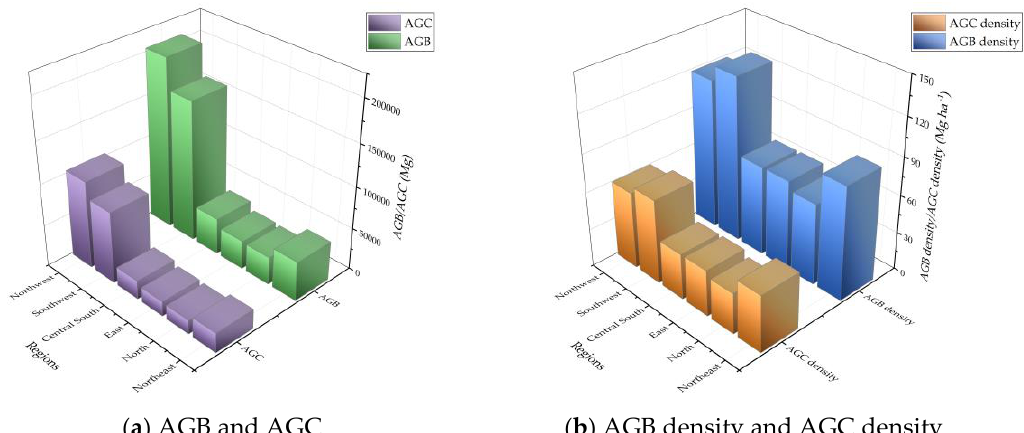
Figure 5. Comparative analysis of differences among regions. ( a , b ) represent the amount and density of aboveground biomass (AGB) and aboveground carbon (AGC), respectively, in the northwest, north, east, central south, southwest and northwest of China. east, central south, southwest and northwest of